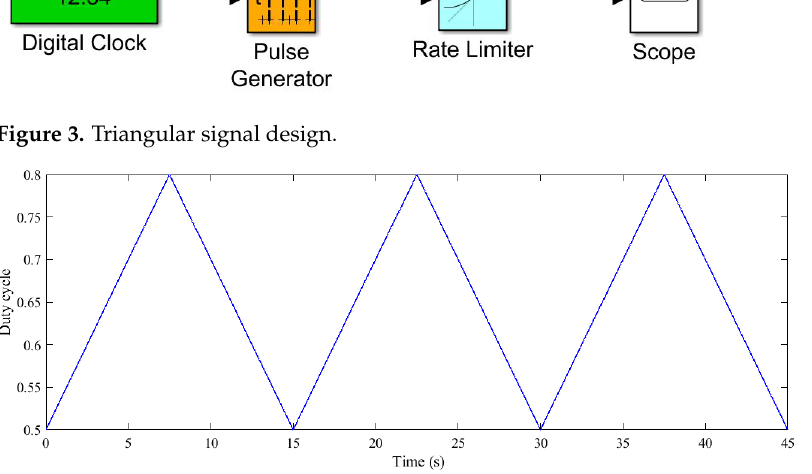
Figure 4. Triangular signal